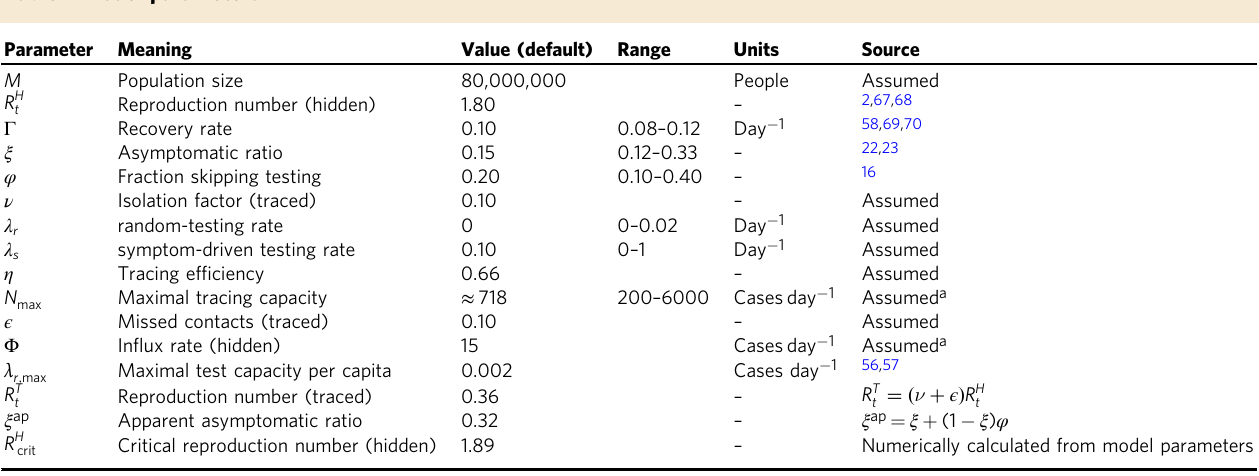
Table 1 Model parameters.